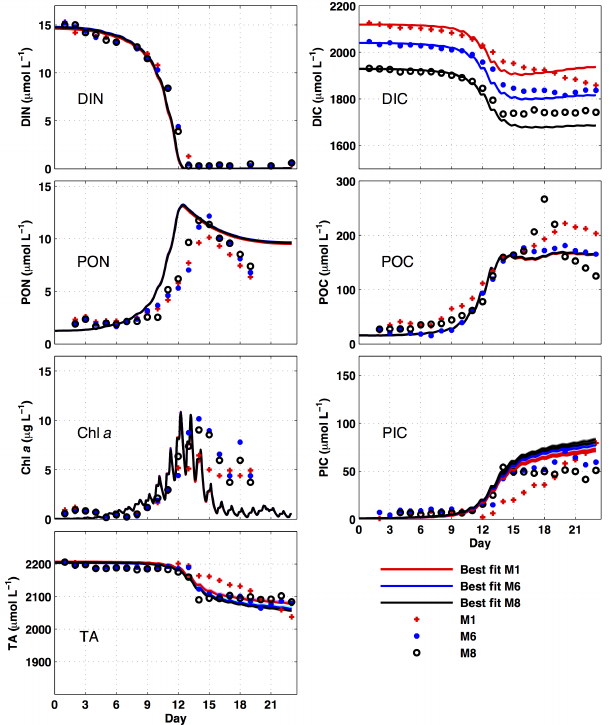
Figure 7. Low calcification solution. The coloured bands represent ensemble of model results according to the posterior and symbols show